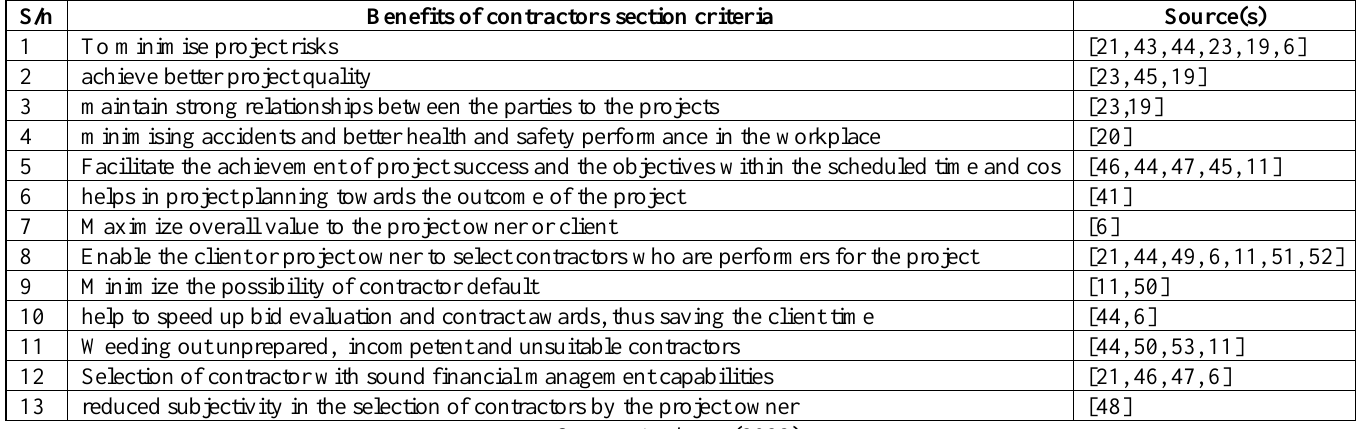
Table 2: Benefits of contractors section criteria in civil engineering